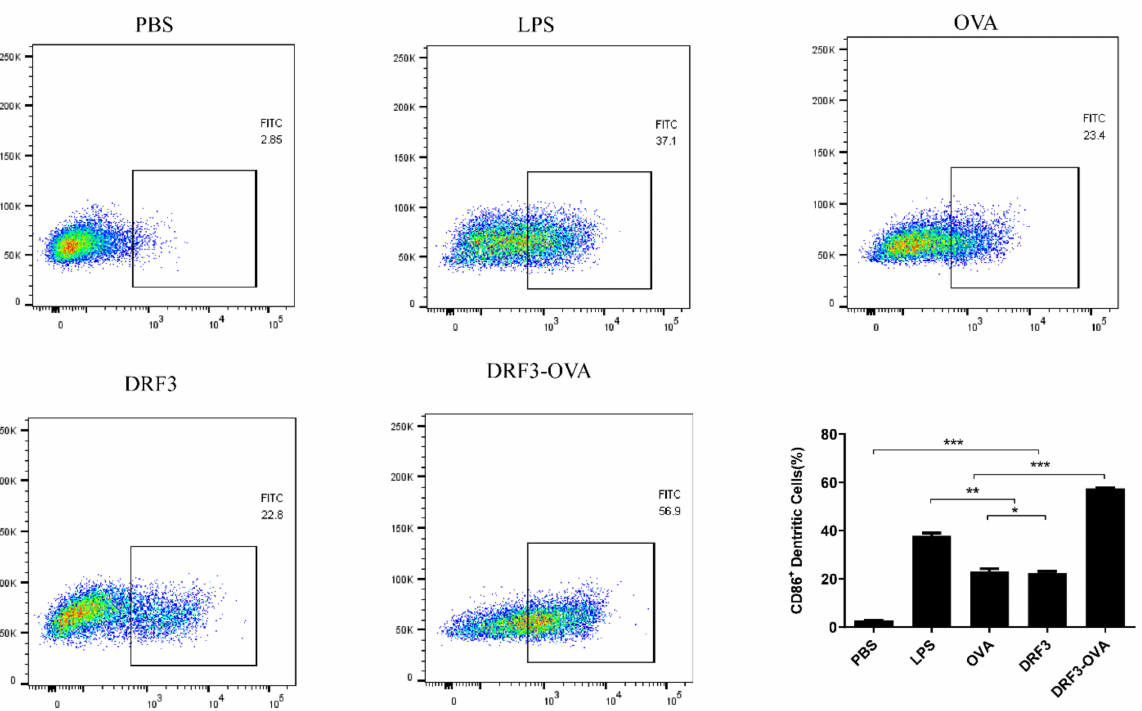
Figure 12. The expression rate of CD86 was detected by flow cytometry (the results were repeated three times, shown as mean ± SEM; * means significant differences p < 0.05; ** means significant differences p < 0.01; *** means significant differences p <